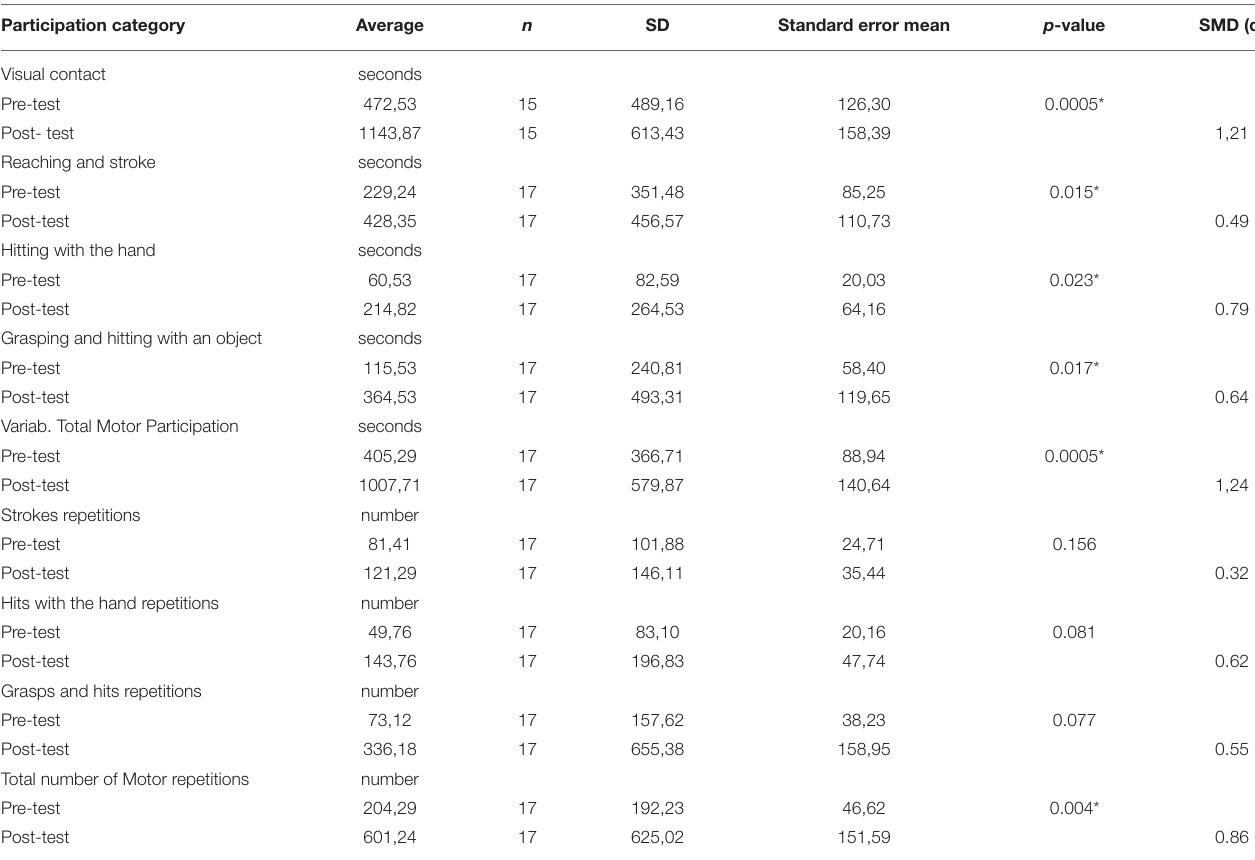
TABLE 3 | Quantification of the participation categories at pre and post